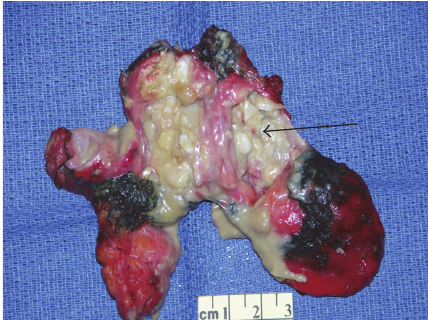
Figure 6: Gross specimen with keratinaceous debris within the cyst (black